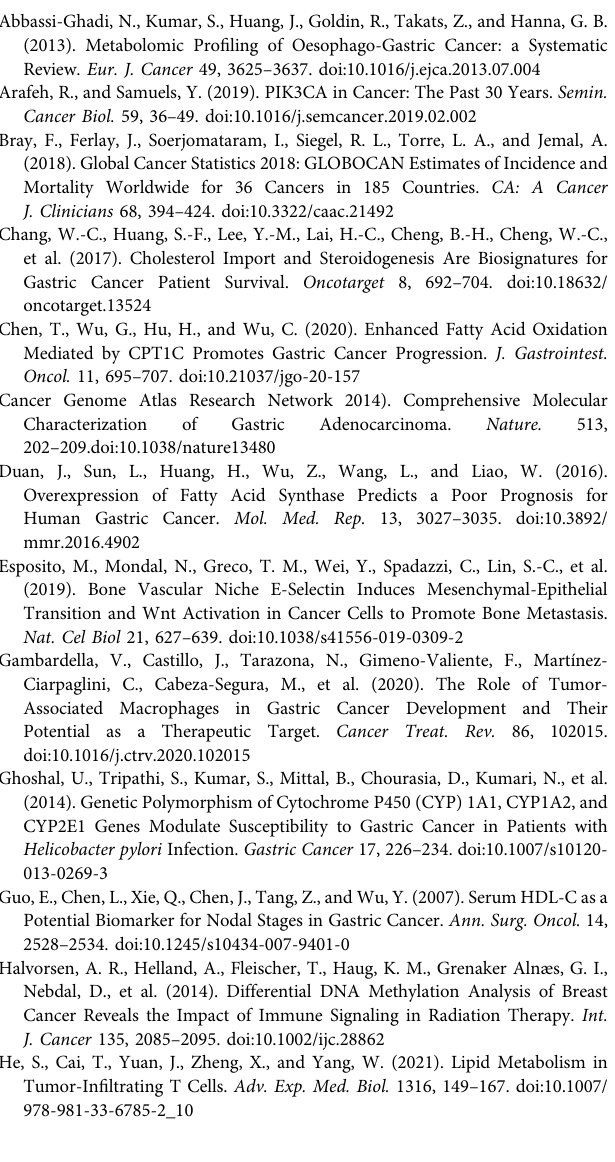
Supplementary Figure 3 | Kaplan – Meier curves of overall survival strati fi ed by risk score (low/high) in another two datasets: TCGA GC dataset (A) and GSE84437 dataset (B) . Supplementary Figure 4 | Subgroup analyses of Kaplan – Meier curves for overall survival strati fi ed by adjuvant chemotherapy (no/yes) and TNM stage (I